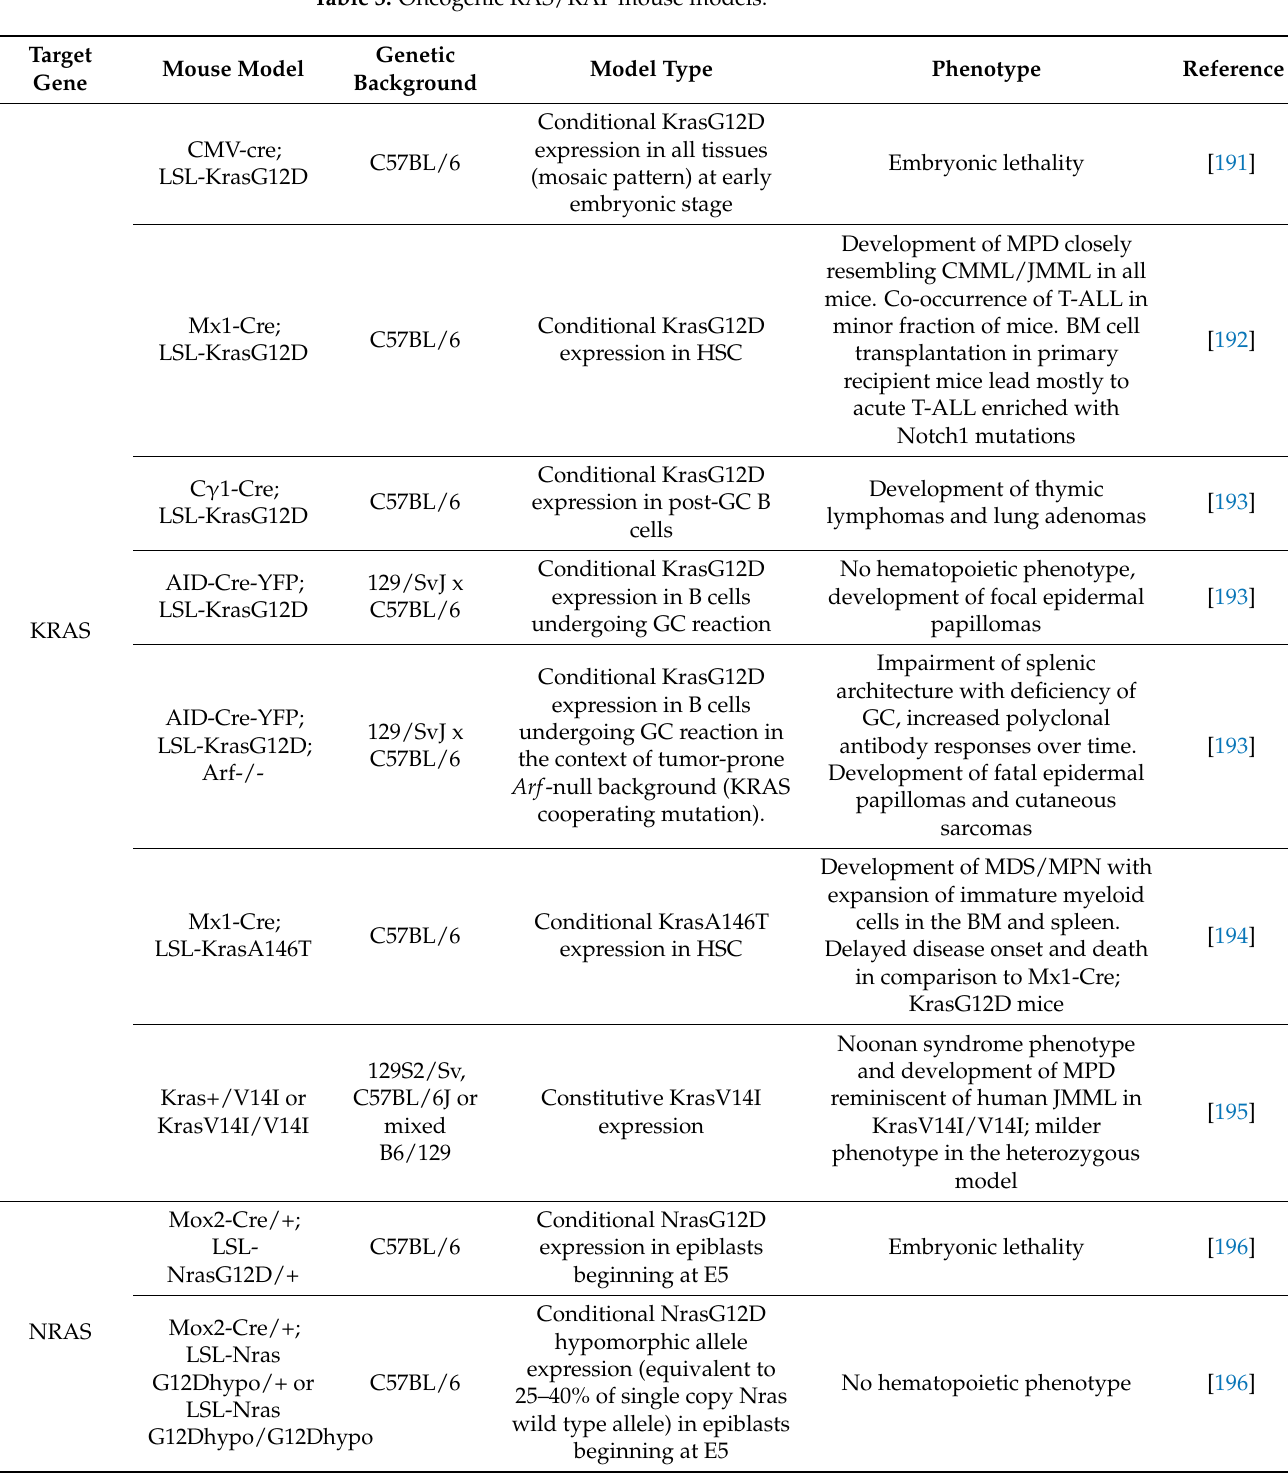
Table 3. Oncogenic RAS/RAF mouse